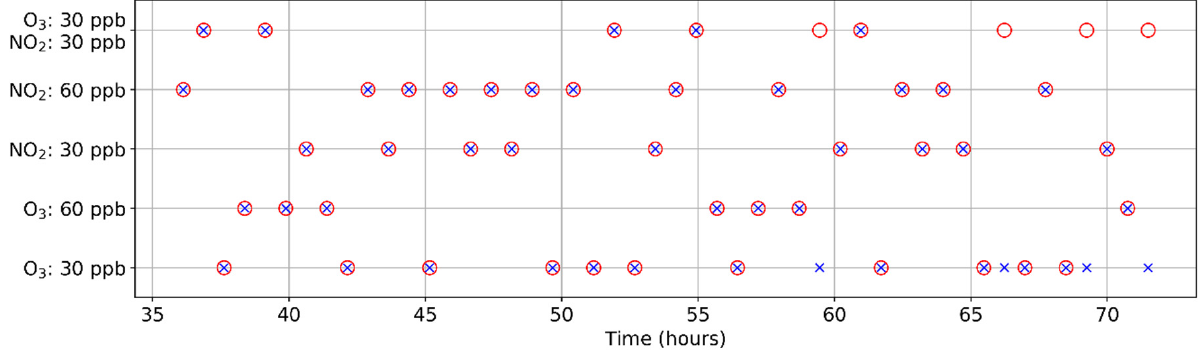
Figure 8. Performance of a trained ANN (9 neurons in 1 hidden layer) on the test data. Red circles represent the expected result; blue crosses represent the predicted